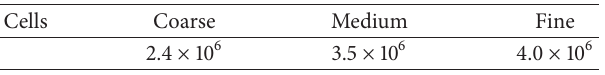
𝑥 𝑝 is the static 𝑖 directions;